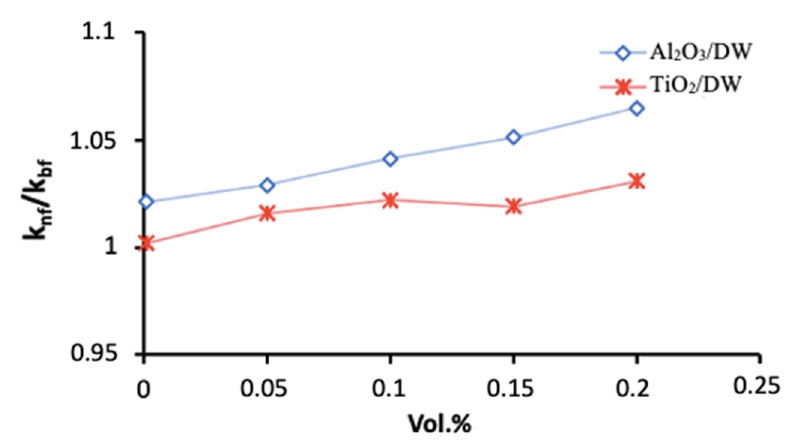
Figure 1. The enhancements of thermal conductivity of NFs as a function of volumetric concentrations of Al 2 O 3 and TiO 2 nanoparticles.